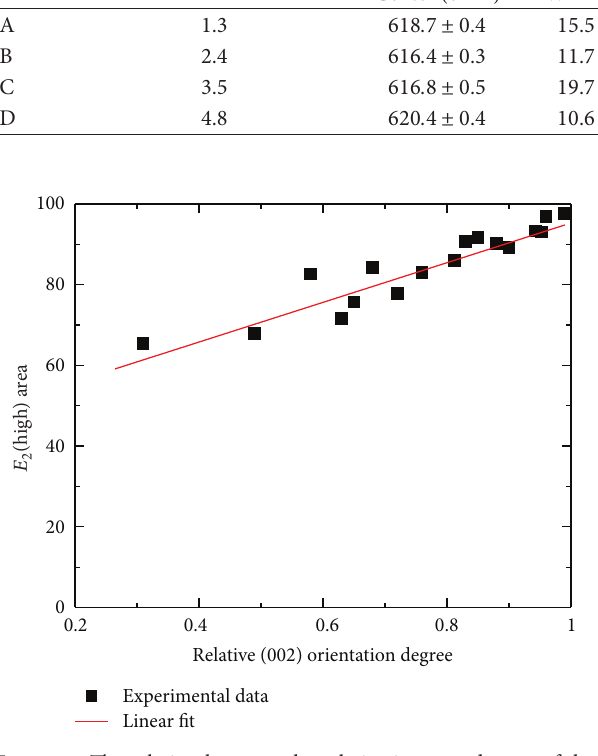
F 6: e FWHM of (high) peaks in Raman spectra as the function of the FWHM of the (002) peaks in X-ray rocking 𝐸𝐸 2